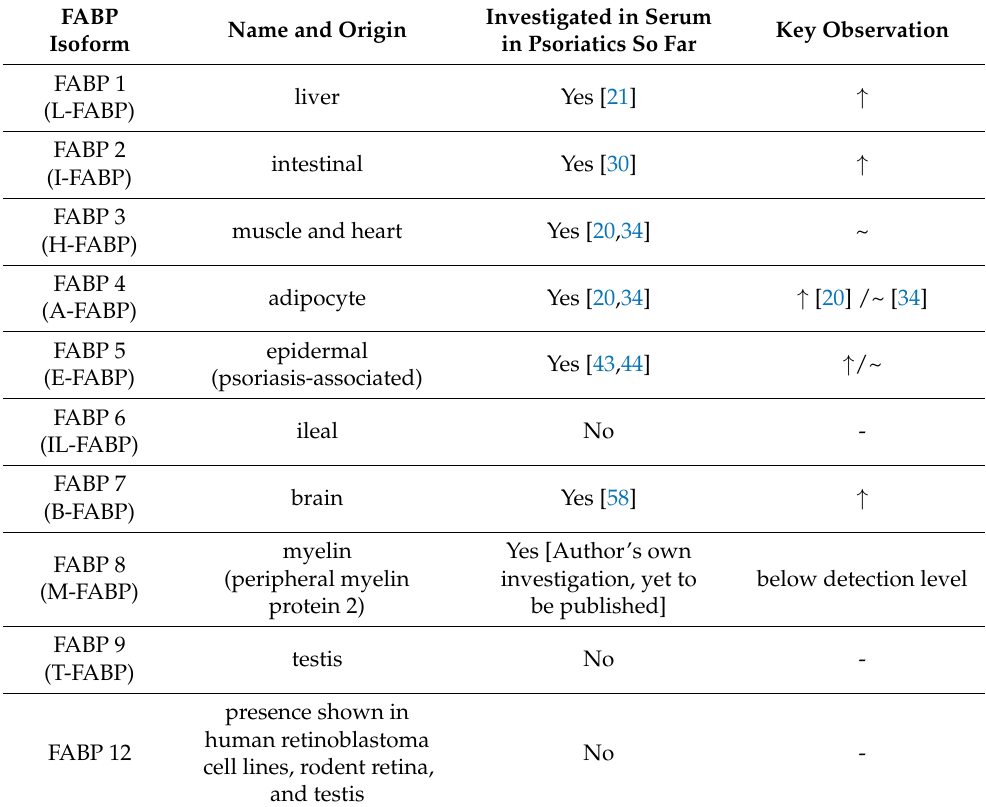
Table 1. Summary of FABP isoforms in relation to psoriasis and their serum